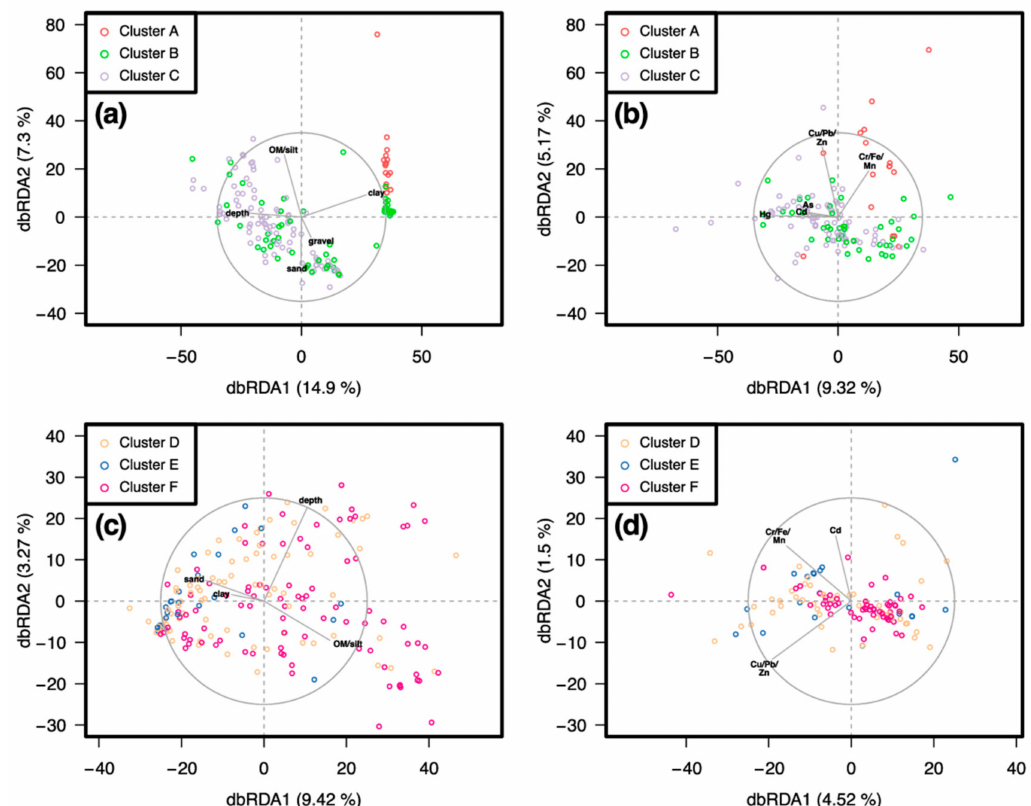
Figure 5. Constrained ordination with a distance-based redundancy analysis for taxa assemblages obtained for the 0.5 mm and 1 mm size classes. Only predictors selected by the distance-based linear modelling (DistLM) are displayed. Point color represents similarity groups defined by the hierarchical agglomerative clustering. ( a ) Ordination for the 0.5 mm size class with organic matter and grain-size classes as predictors (Model 1); ( b ) Ordination for the 0.5 mm size class with heavy metal concentrations as predictors (Model 2); ( c ) Ordination for the 1 mm size class with organic matter and grain-size classes as predictors (Model 1); ( d ) Ordination for the 1 mm size class with heavy metal concentrations